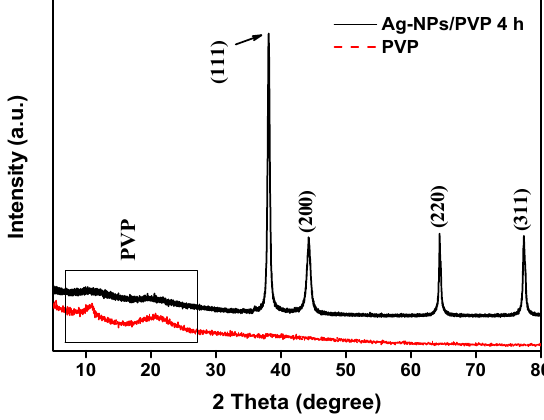
Figure 3. XRD patterns of PVP and Ag-NPs reacted for 4 h.